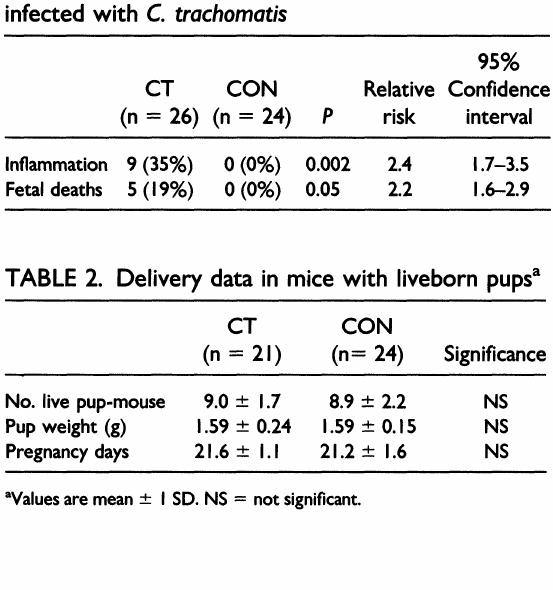
TABLE I. Adverse pregnancy outcome data in mice infected with C. trachomatis